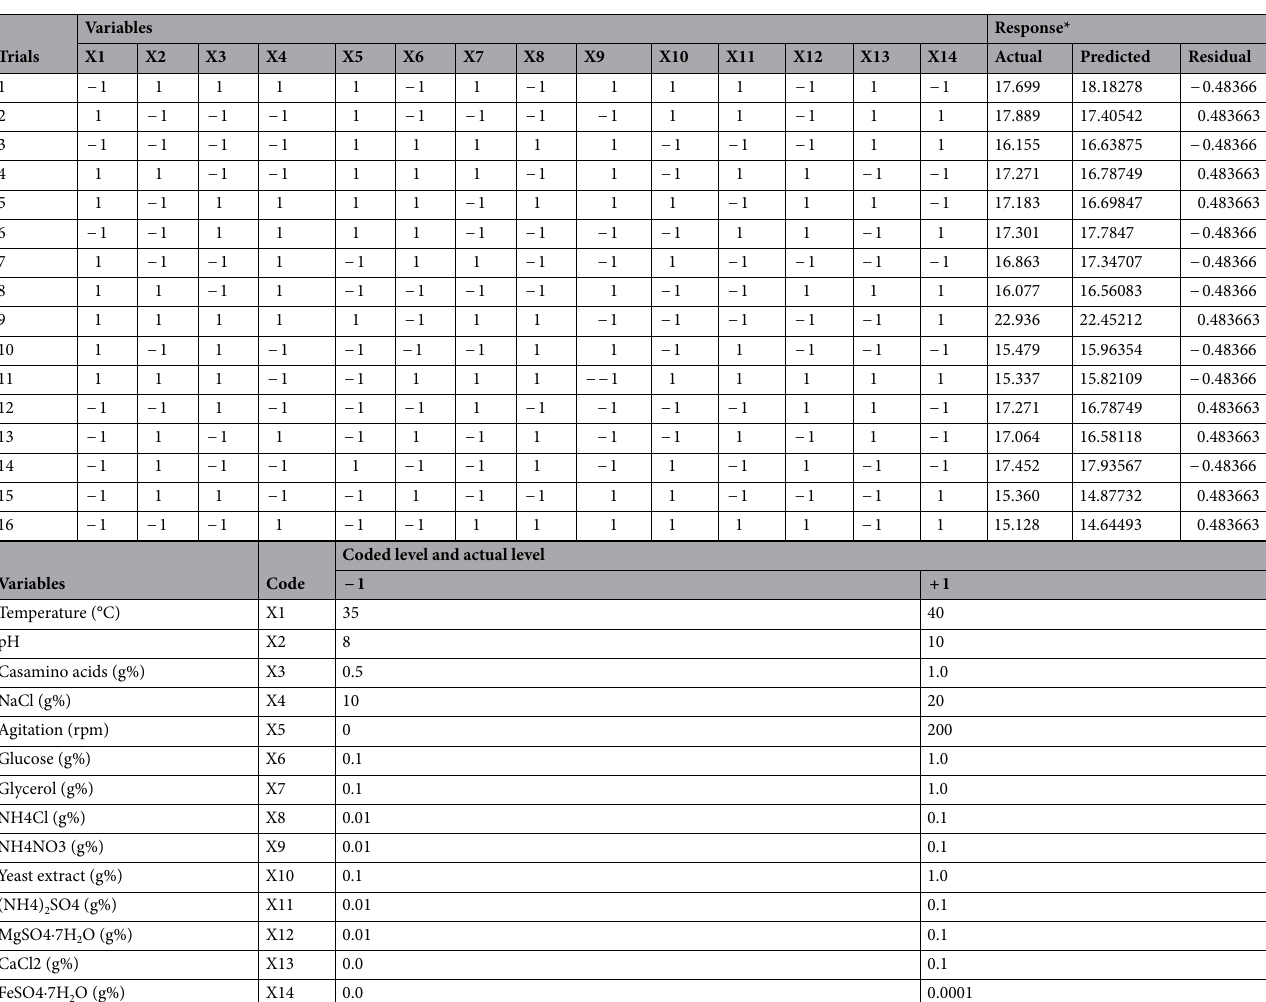
Table 3. PB experimental design for the evaluation of the factors influencing biosurfactant activity of Natrialba sp. M6. Triple tests were performed and the average of three reading was considered as the final. *Response is the reciprocal of the measured ST ×